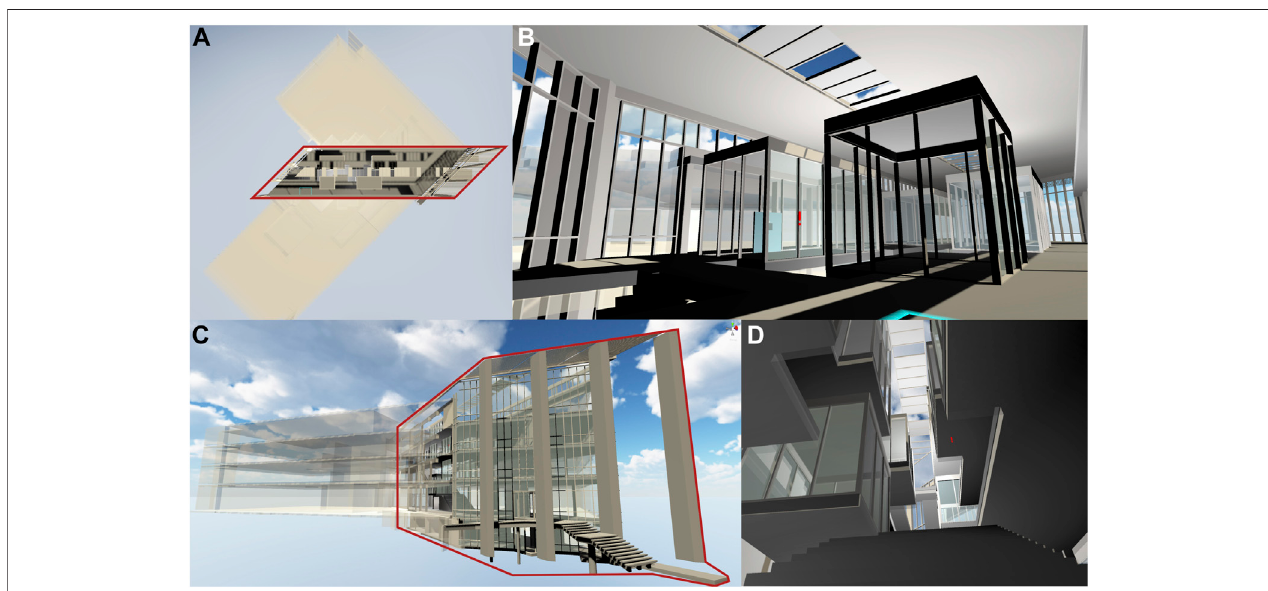
FIGURE4| ExteriorandinteriorshotsoftheLuddyHallmodel. (A) :Topviewwithatriumhighlightedpurple. (B) :4th fl oornearstarcase,startpointforallnavigation tasks. (C) : Side view, atrium highlighted. (D) : View from fi rst fl oor up the central staircase.